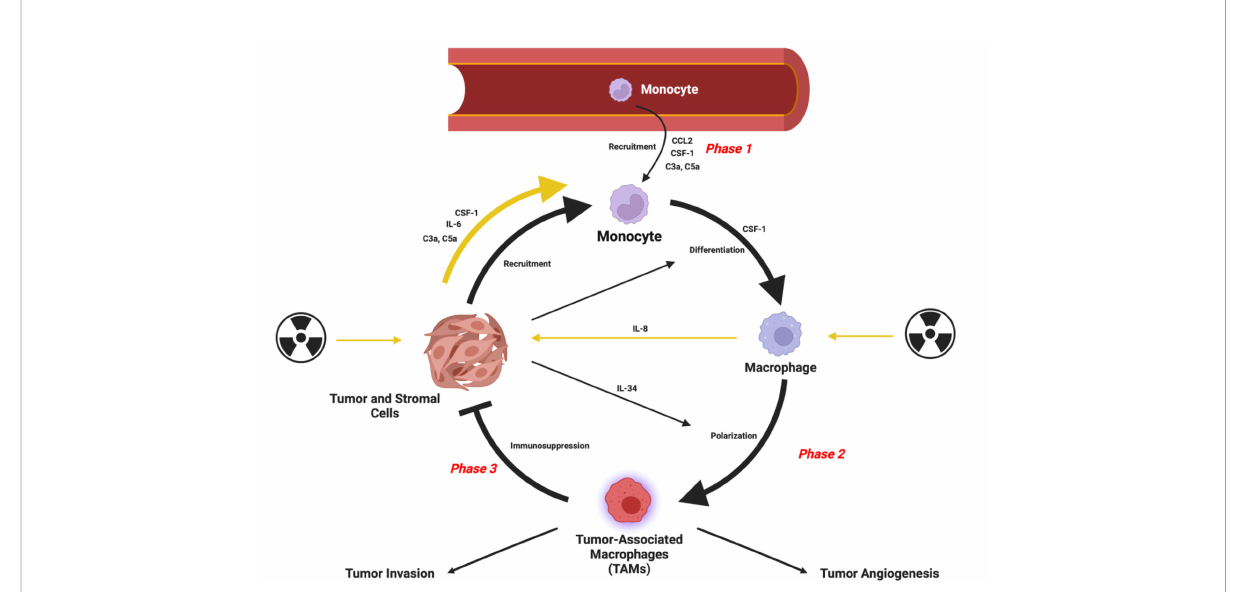
FIGURE 1 Schematic representation of the role of TAMs in tumor progression. Radiation can contribute to recruitment and polarization as indicated by the yellow arrows. Figure created in Biorender. Agreement number: